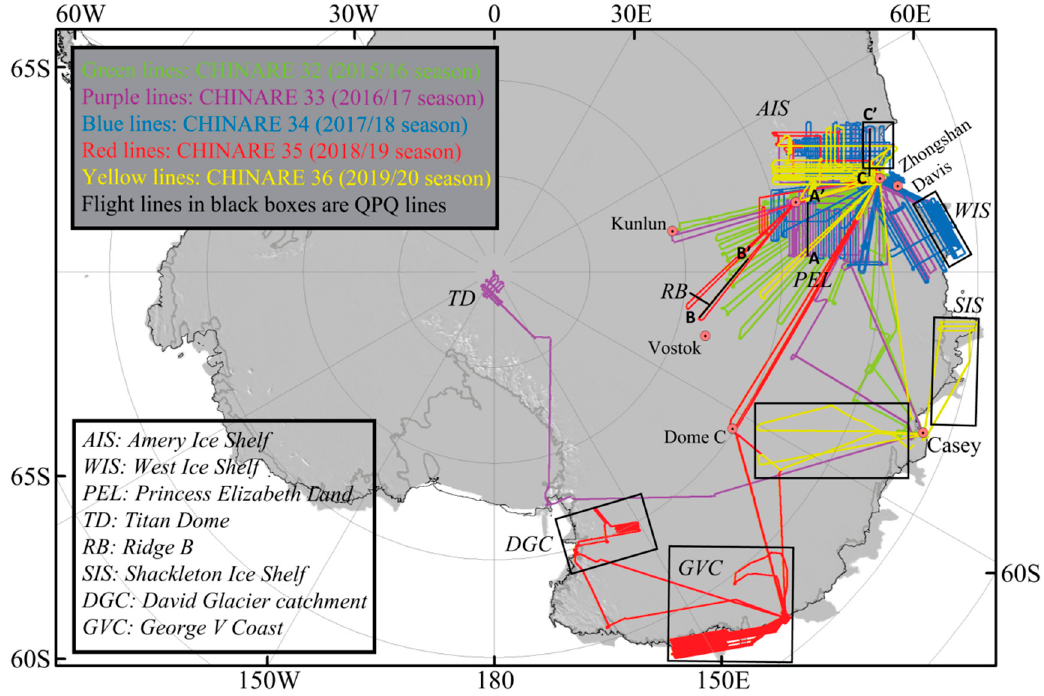
Figure 5. Flight line coverage of airborne surveys in the past five austral seasons by Snow Eagle 601. Profiles along A-A’, B-B’ and C-C’ are shown in Figure 6.